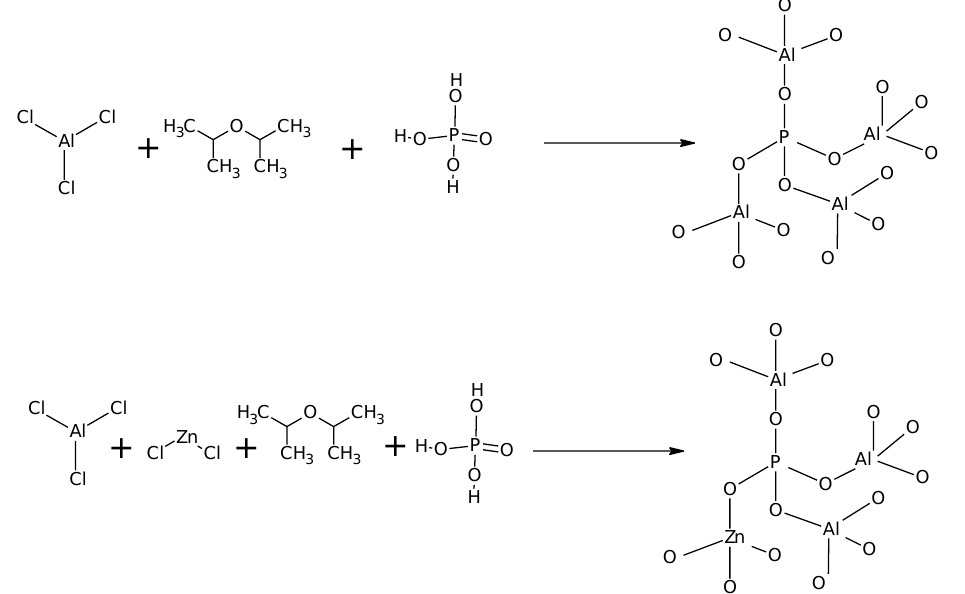
Figure 2. Schematic representation of the synthesis of aluminum phosphate (Zn-AlPO 4 ) via the non-hydrolytic sol – gel process.